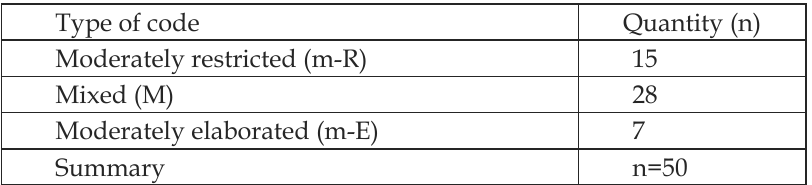
Table 1 . Registered types of